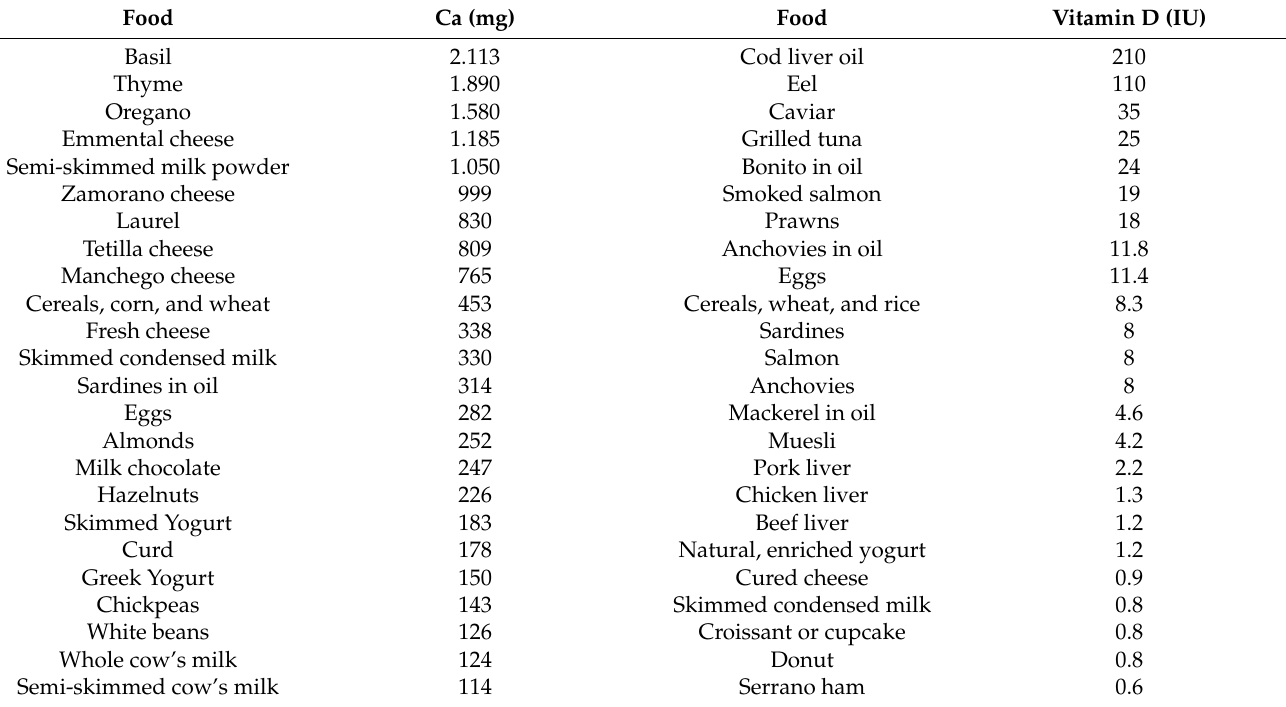
Table 2. Food calcium and vitamin D content (from ref. [11]).